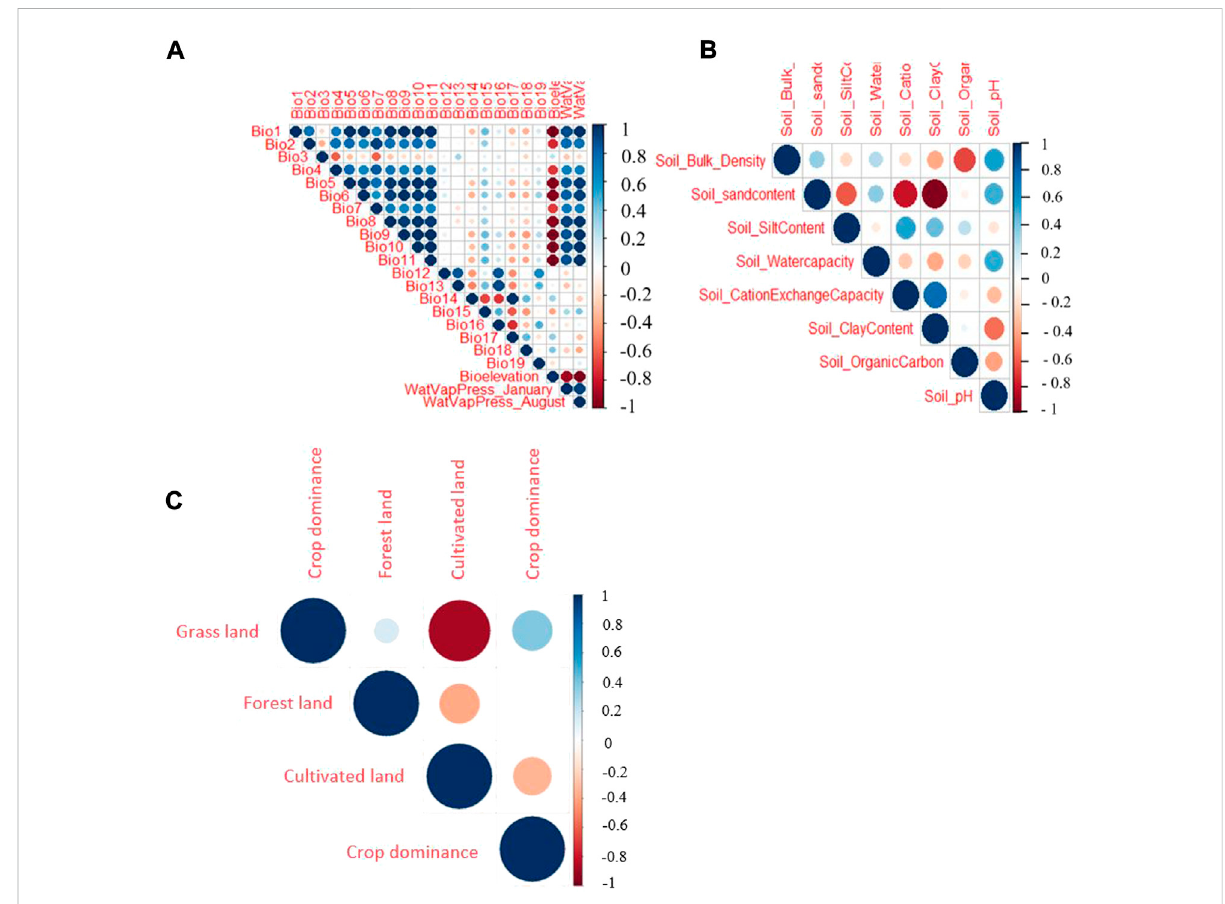
FIGURE 3 Spearmancorrelationtestforthreedifferentgroupsofclimaticandenvironmentalparametersevaluated (A) Climaticvariables, (B) soilvariables, (C) vegetation and land cover